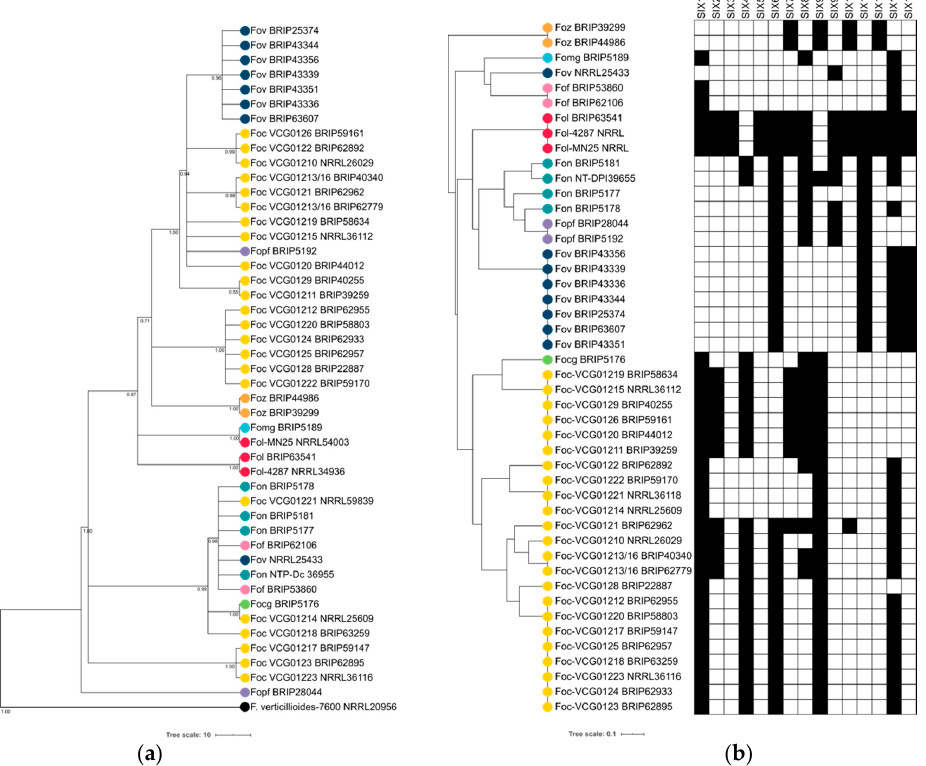
Figure 3. Hierarchical clustering analysis of the presence/absence of secreted in xylem ( SIX ) genes demonstrates a better association with the formae speciales of Fusarium oxysporum as compared to conventional phylogenetic analyses. ( a ) Genetic relationships of plant pathogenic formae speciales of F. oxysporum determined from an alignment and Bayesian analysis of the translation elongation factor 1- α ( EF1- α ). ( b ) Hierarchical clustering was used to analyse the SIX gene presence/absence matrix and generate a cluster dendogram for the formae speciales of F. oxysporum . The SIX gene presence/absence matrix used for the cluster analysis is given adjacent to the cluster dendrogram. A solid block indicates gene presence and a blank block indicates gene absence. Pathogenic formae speciales of F. oxysporum are indicated with a coloured